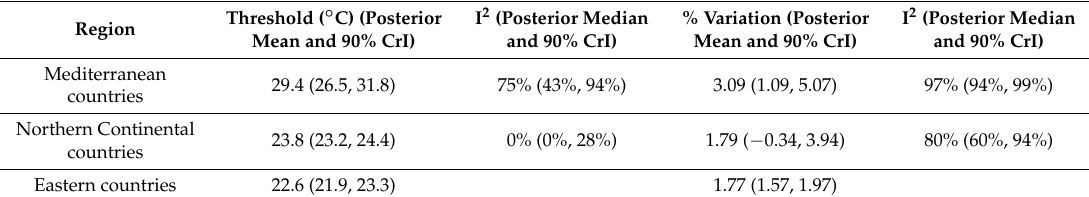
Table 2. Summaries of the posterior distributions of threshold, % variation associated to 1 ◦ C increase in maximum apparent temperature above the threshold and I 2 index for Mediterranean, Northern-continental and Eastern countries.